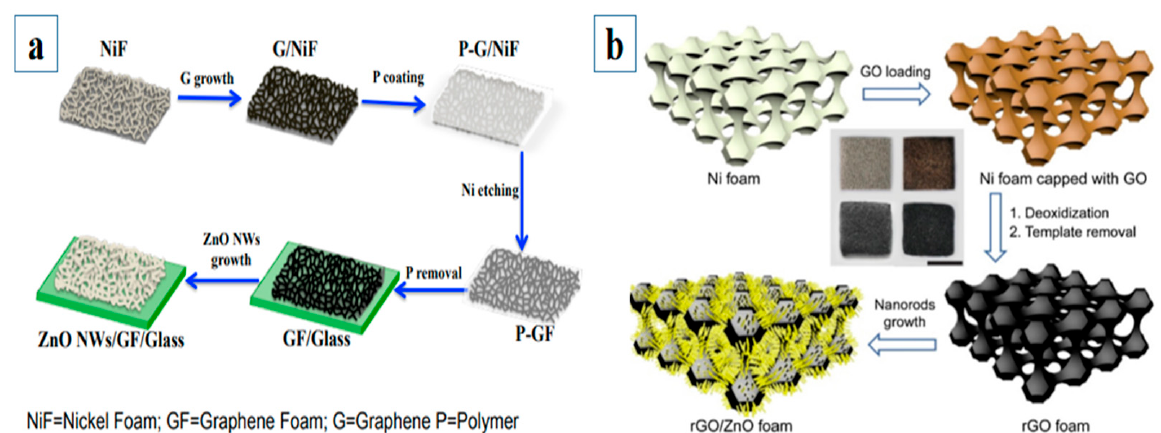
Figure 9. ( a ) Schematic of steps involved in ZnO nanowire–3D graphene network sample fabrication; ( b ) schematic diagram of preparation of the free-standing ZnO/rGO foam.